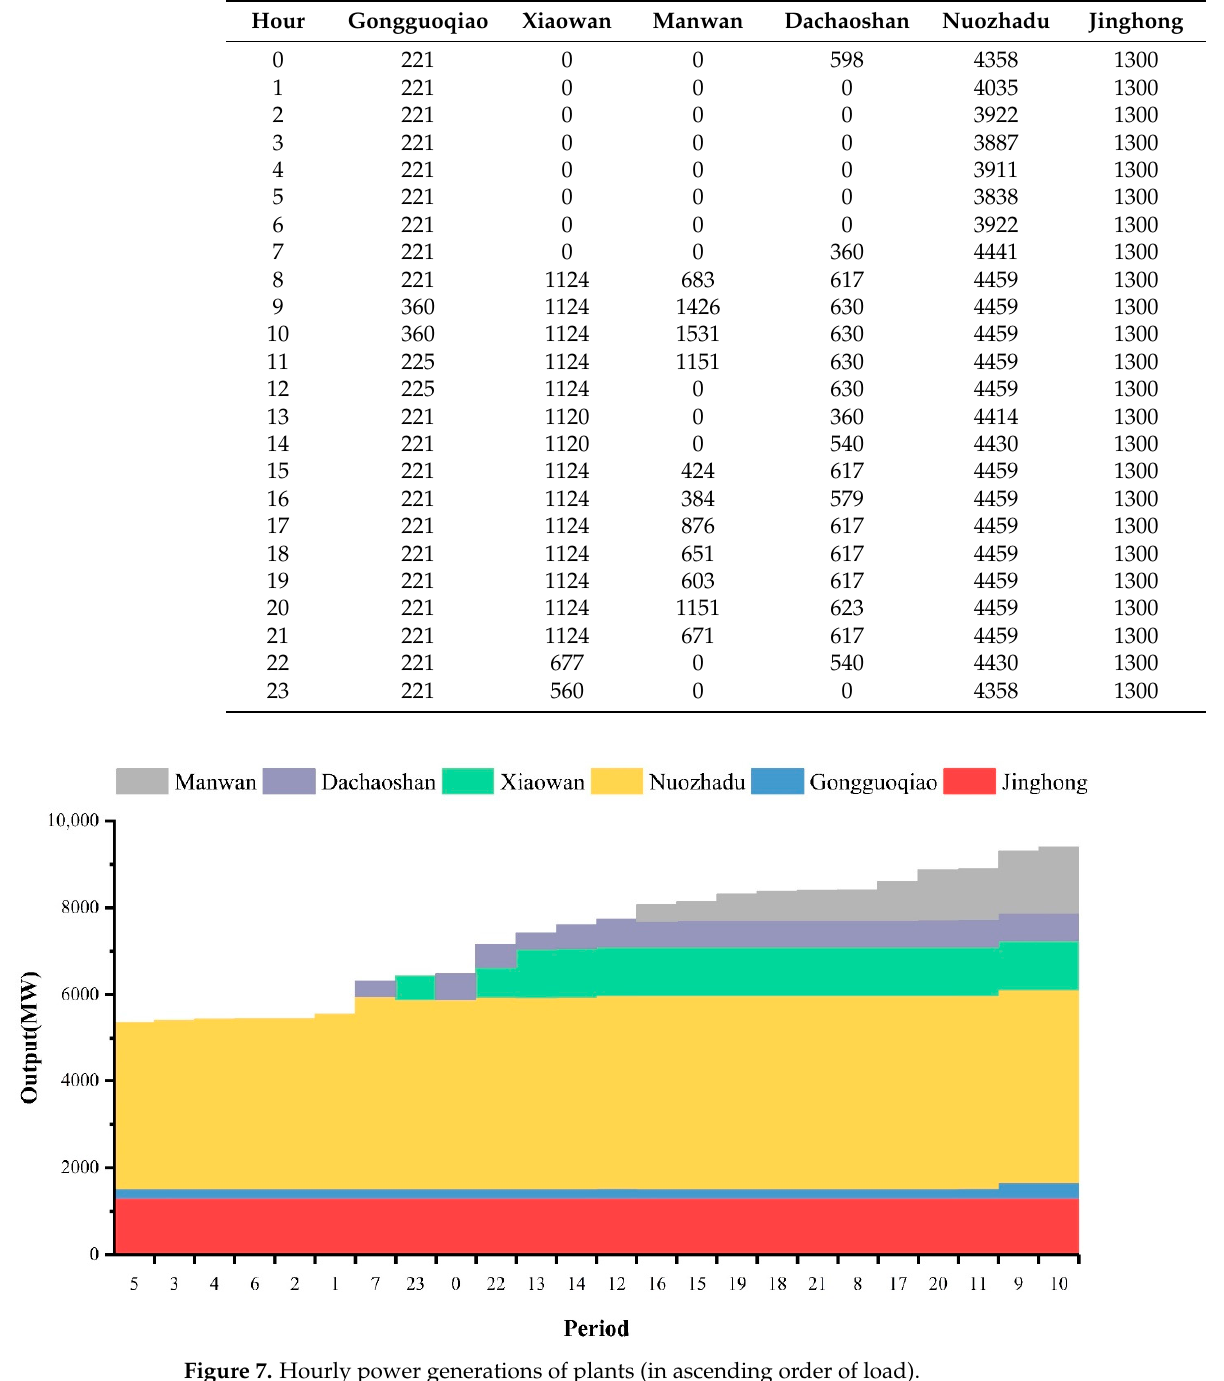
Table 3. Hourly power generations of plants.